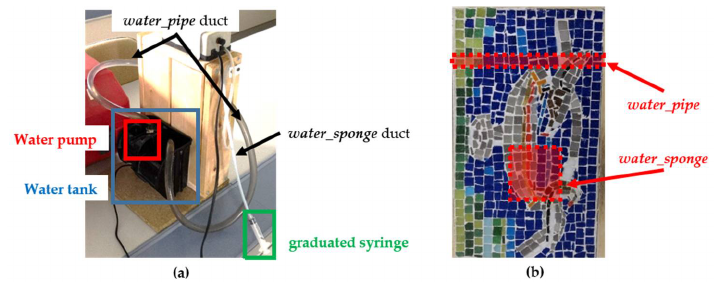
Figure 2. ( a ) Water tank, water pump, graduated syringe, water_pipe and water_sponge ducts positions; ( b ) water_pipe and water_sponge locations from the front surface of the mosaic.